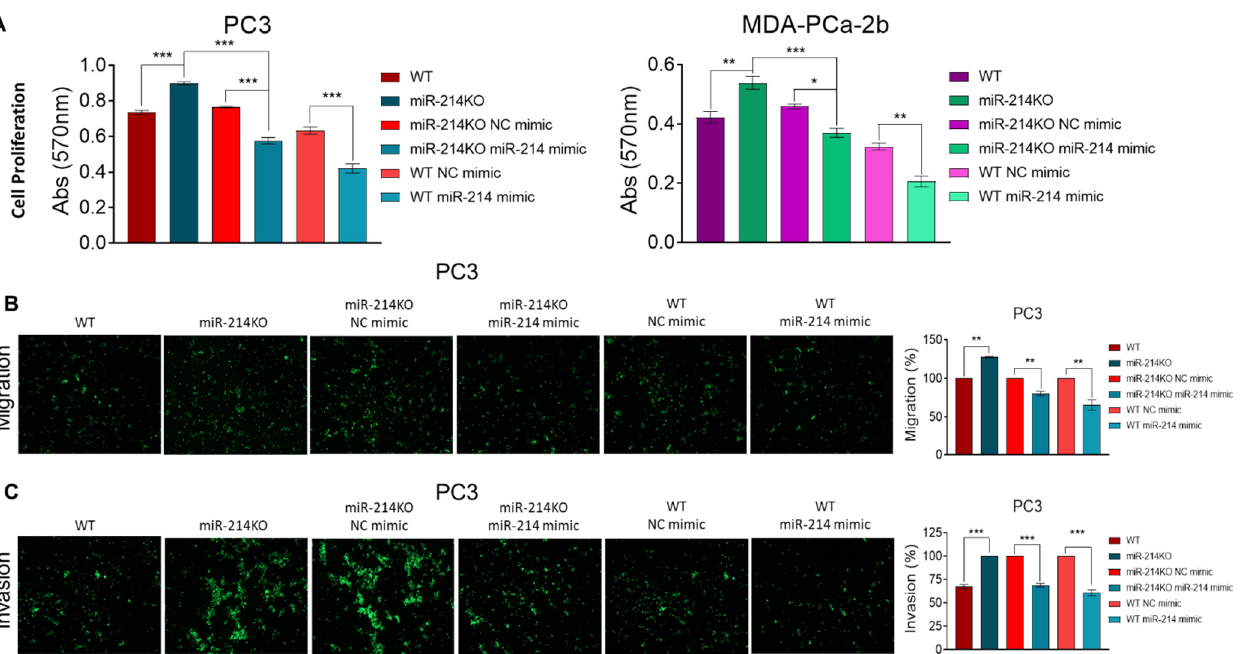
Figure 3. Overexpression of miR-214 partially reverses the silencing of miR-214 induced proliferative, migratory, and invasive effects. WT and miR-214KO PCa cells were transfected with NC mimic or miR-214 mimic. ( A ) After 48 h, the effect of the miR-214 expression on cell proliferation was determined by MTT assay. Migration ( B ) and invasion ( C ) ability were analyzed by transwell invasion assay in WT and miR-214KO miR-214 transfected PC3 cells, left panel, and quantified in the right panel. Pairwise normalization of WT vs miR-214KO; miR-214KO NC mimic vs miR-214KO miR-214 mimic; and WT NC mimic vs WT miR-214 mimic. Data are presented as mean ± SEM one-way ANOVA using Tukey’s multiple comparisons test, * p < 0.05, ** p < 0.005, *** p < 0.0005.